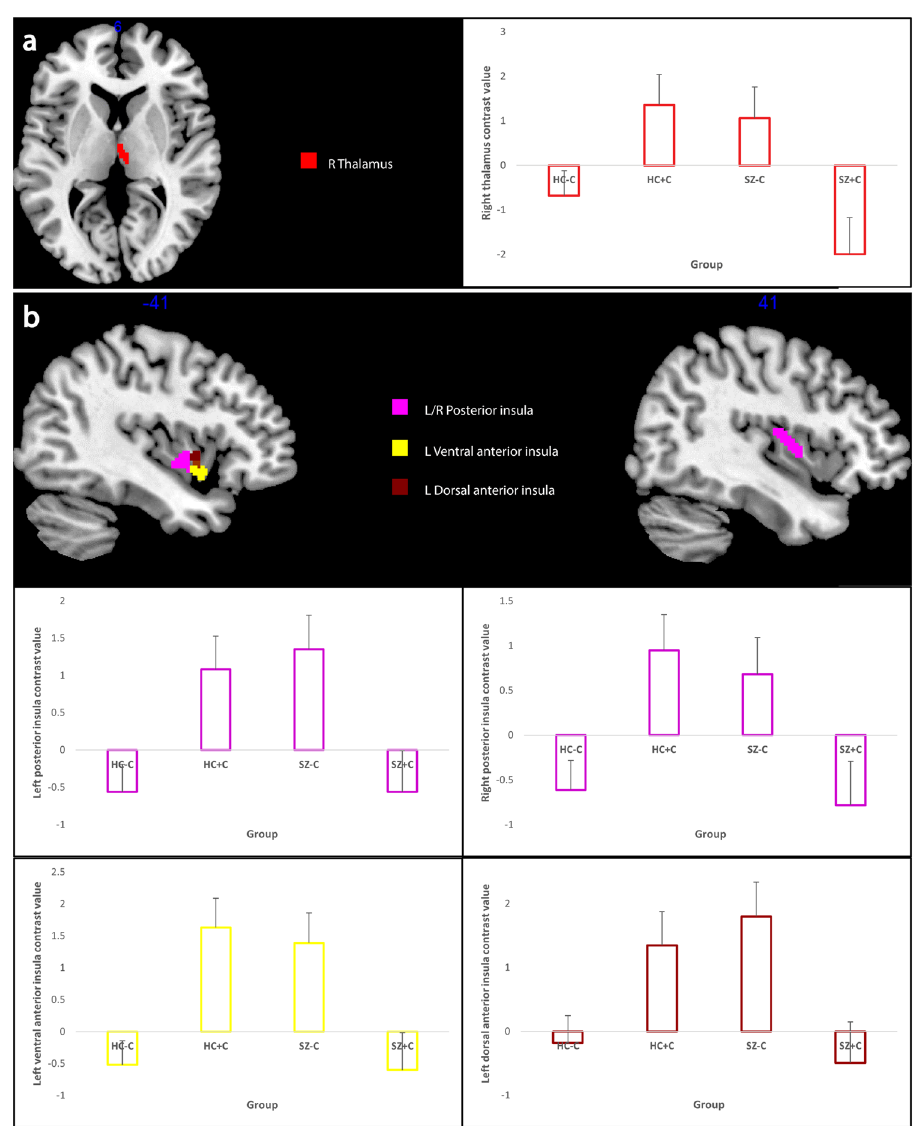
Fig. 3 Main analysis. Clusters showing signi fi cant modulation by the interaction of cannabis and schizophrenia for the reward versus punishment contrast ( a ) and the magnitude contrast ( b ). Clusters thresholded at p < 0.005 for visualisation purposes. Red = thalamus; yellow = ventral anterior insula; brown = dorsal anterior insula; violet = posterior insula. The bar plots show mean beta values for each cluster for each group and error bars show standard errors of the mean beta values. HC − C non-cannabis user healthy controls, HC + C cannabis-user healthy controls, SZ − C non-cannabis user schizophrenia patients, SZ + C cannabis-user schizophrenia